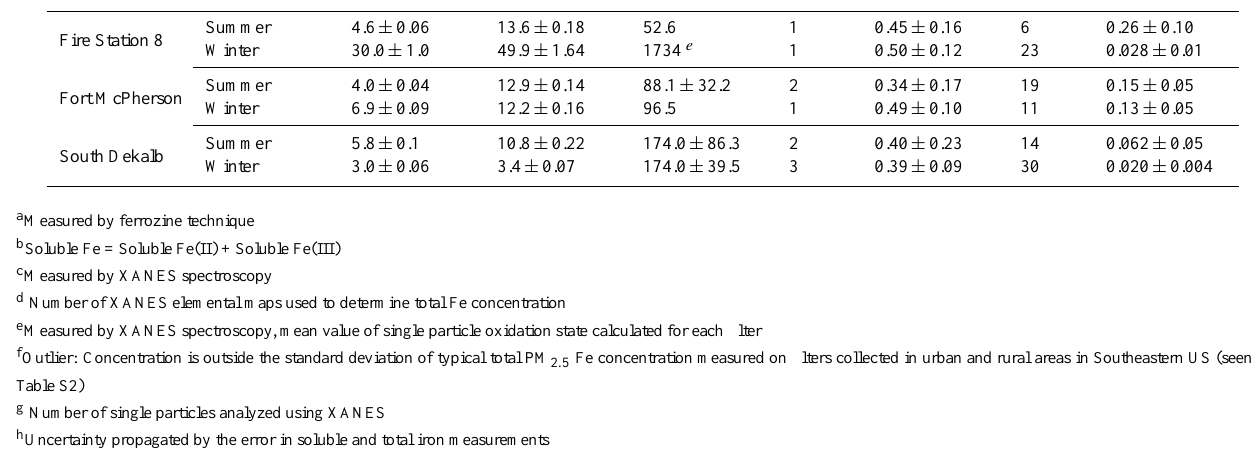
Table S2) g Number of single particles analyzed using XANES h Uncertainty propagated by the error in soluble and total iron measurements